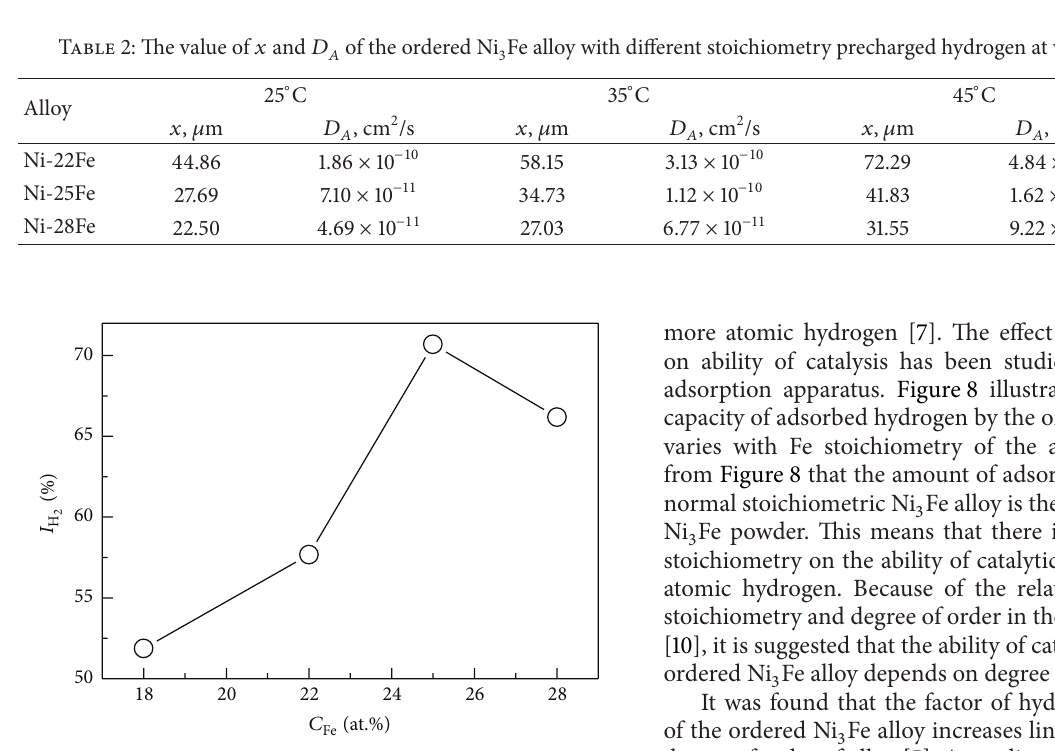
Figure 5: The factor of hydrogen embrittlement of the ordered Ni 3 Fe versus Fe